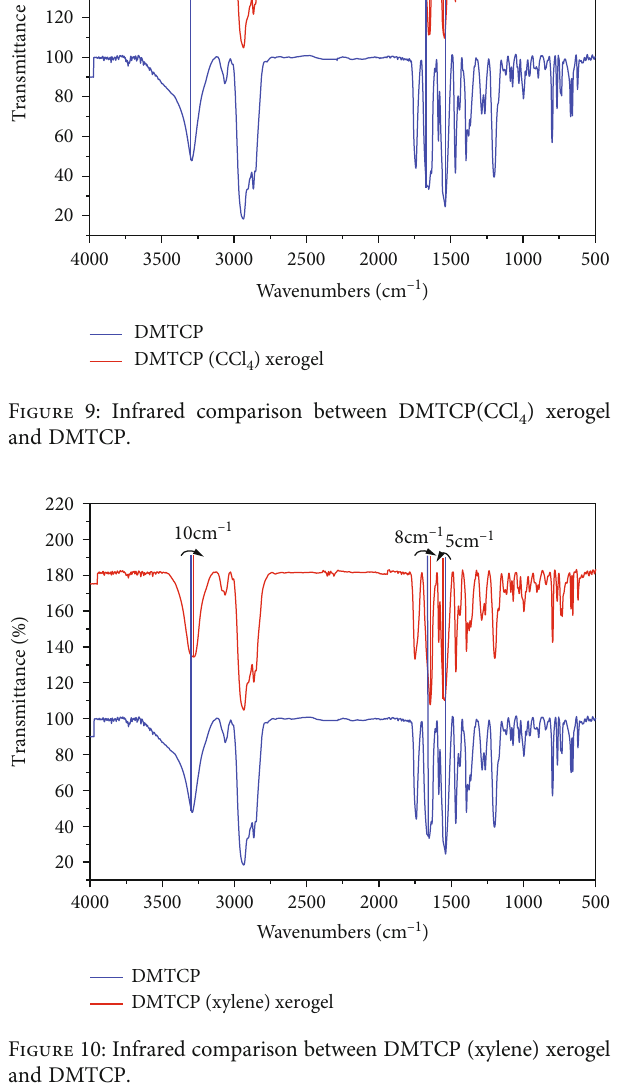
Figure 10: Infrared comparison between DMTCP (xylene) xerogel and DMTCP.